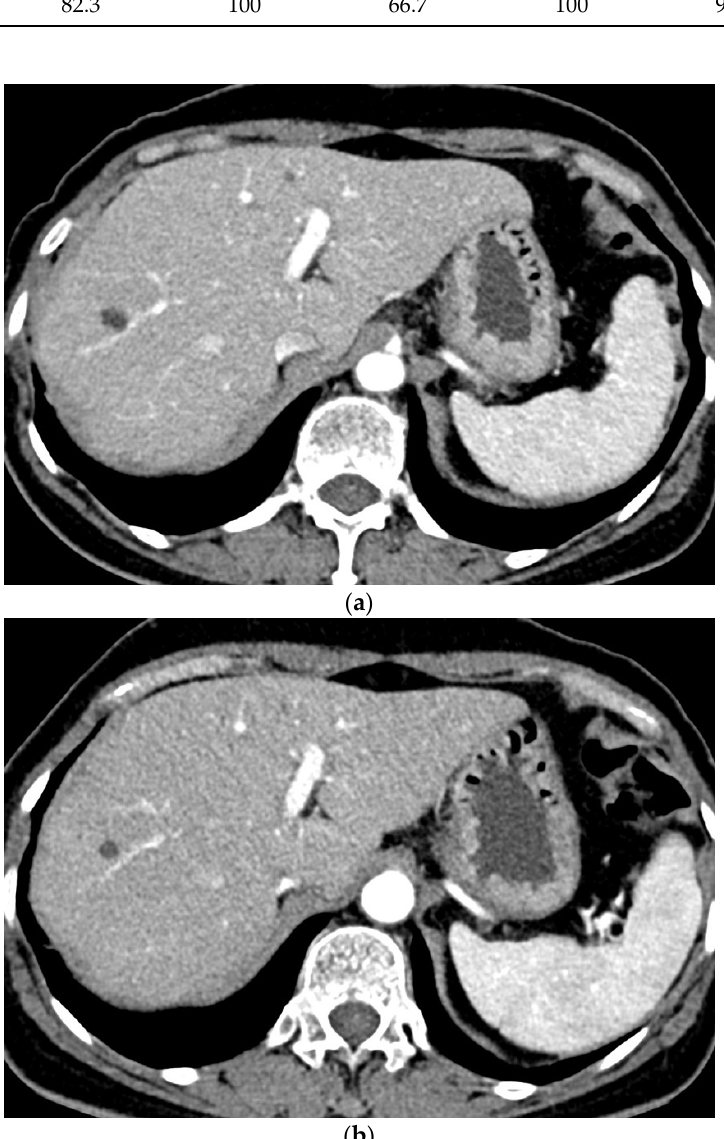
Figure 3. A 64-year-old female patient who underwent CT examinations using the same machine (machine B). An approximately 0.7-cm cyst is noted in liver segment 8 on both CT examinations with 240 mgI/mL contrast material ( a ) and 320 mgI/mL contrast material ( b